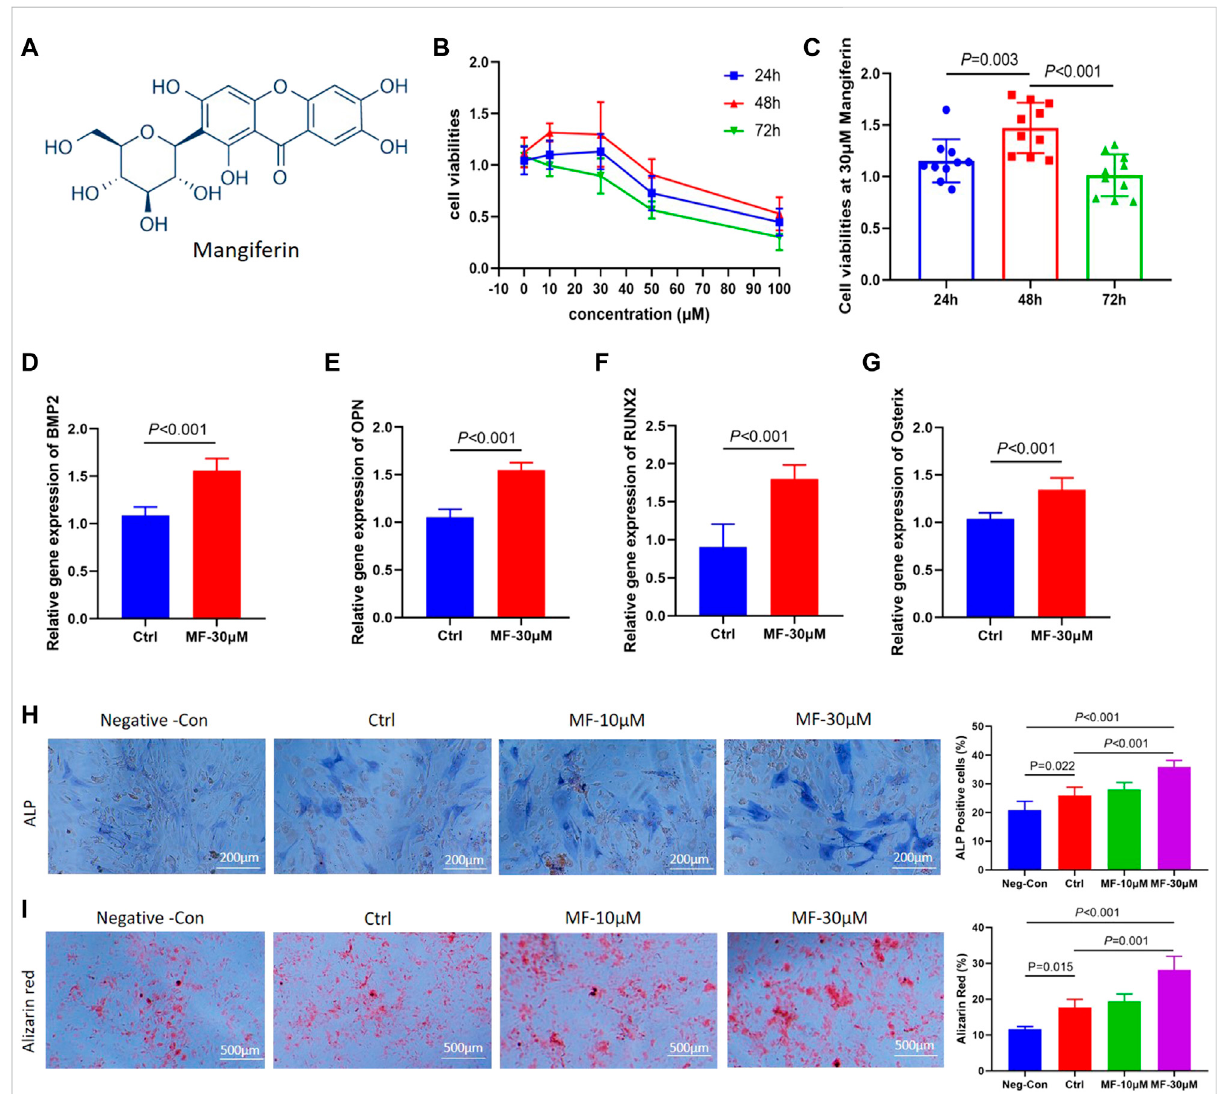
FIGURE 1 (A) . The molecular formula of Mangiferin. (B) Line chart view. The cell viability of MC3T3-E1 cells decreased when the concentration of mangiferin exceed 30 μ M, when the intervention duration was 48 h, the cell viability presented the highest level. (C) Histogram view. When compared with 24 h and 72 h, the cell viability of MC3T3-E1 cells signi fi cantly increased when the duration was 48 h ( p < 0.01). (D – G) . The relative gene expressionof BMP2, OPN, Osterix, and Runx2 signi fi cantly increased when the MC3T3-E1 cells were intervened by MF-30 μ M mangiferin in the osteogenic culture for 14 days (compared with the control group, p < 0.01, respectively). (H) Microscopic observation. The ALP activity in the MF-10 μ MandMF-30 μ Msigni fi cantlyincreased whencompared with thecontrol group( p < 0.05, respectively). (I) Invisualobservation, theAlizarin intensity red inthe 10 μ Mand 30 μ Msigni fi cantly increased when compared with thecontrol group ( p < 0.05, respectively). Therewas no signi fi cant difference in the percent of Alizarin red between MF-30 μ M and the positive-control group ( p > 0.05). Note: MF, Mangiferin. Neg-Con, Negative control. Ctrl, osteogenic induction